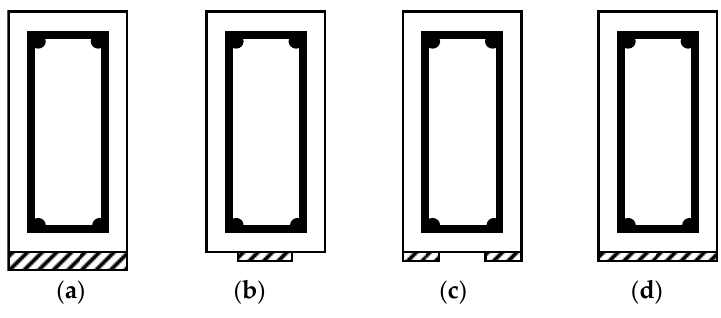
Figure 20. CFRP laminates for the flexural strengthening of girders: ( a ) two-layer sheet ( b ) one-layer strip ( c ) one-layer strips ( d ) one-layer sheet.